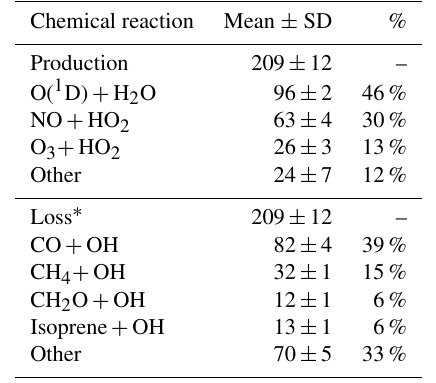
Table 2. Multimodel mean ± standard deviation (SD) of annual total OH production (P) and loss (L) in teramoles per year and per- centage contribution of each production and loss process to total OH production and loss estimated with multimodel mean OH fields ∗ .